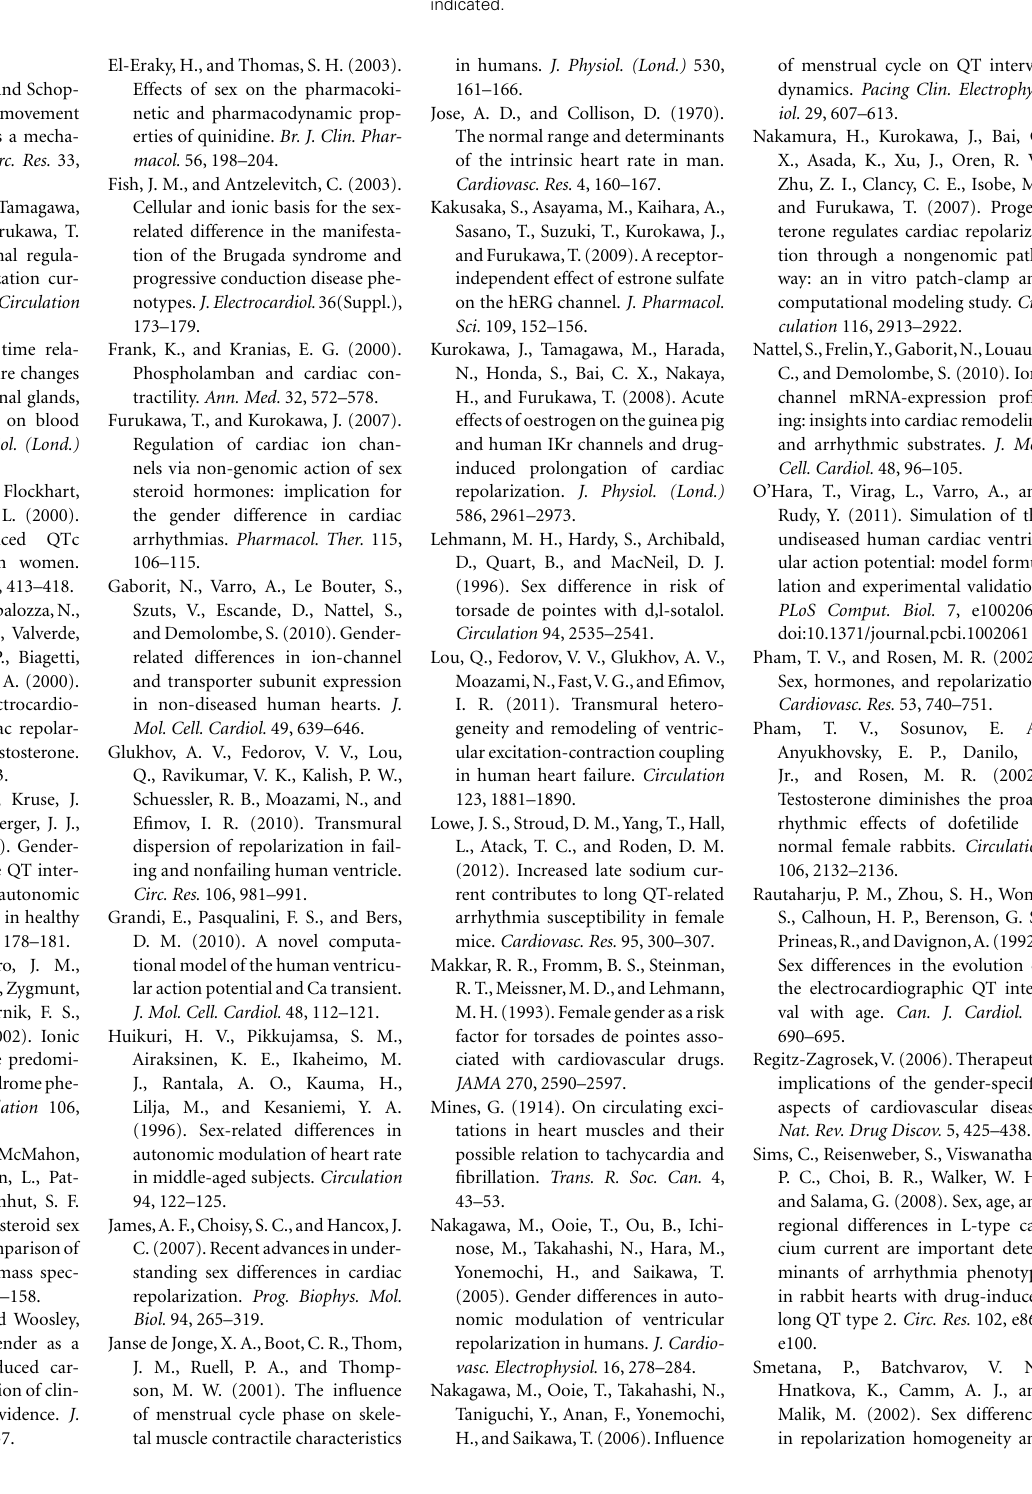
Figure S8 | SimulatedAPs under SNS stimulations for the 1000th paced beat at a cycle length of 1000ms in single endocardial and epicardial cell. Estrogen and progesterone at different physiological concentrations corresponding to three stages of the menstrual cycle were added in female cells: early follicular phase (estrogen: 0.1nM and progesterone: 2.5nM), late follicular phase (estrogen: 1nM and progesterone: 2.5nM) and luteal phase (estrogen: 0.7nM and progesterone: 40.6nM).The APD for each case is